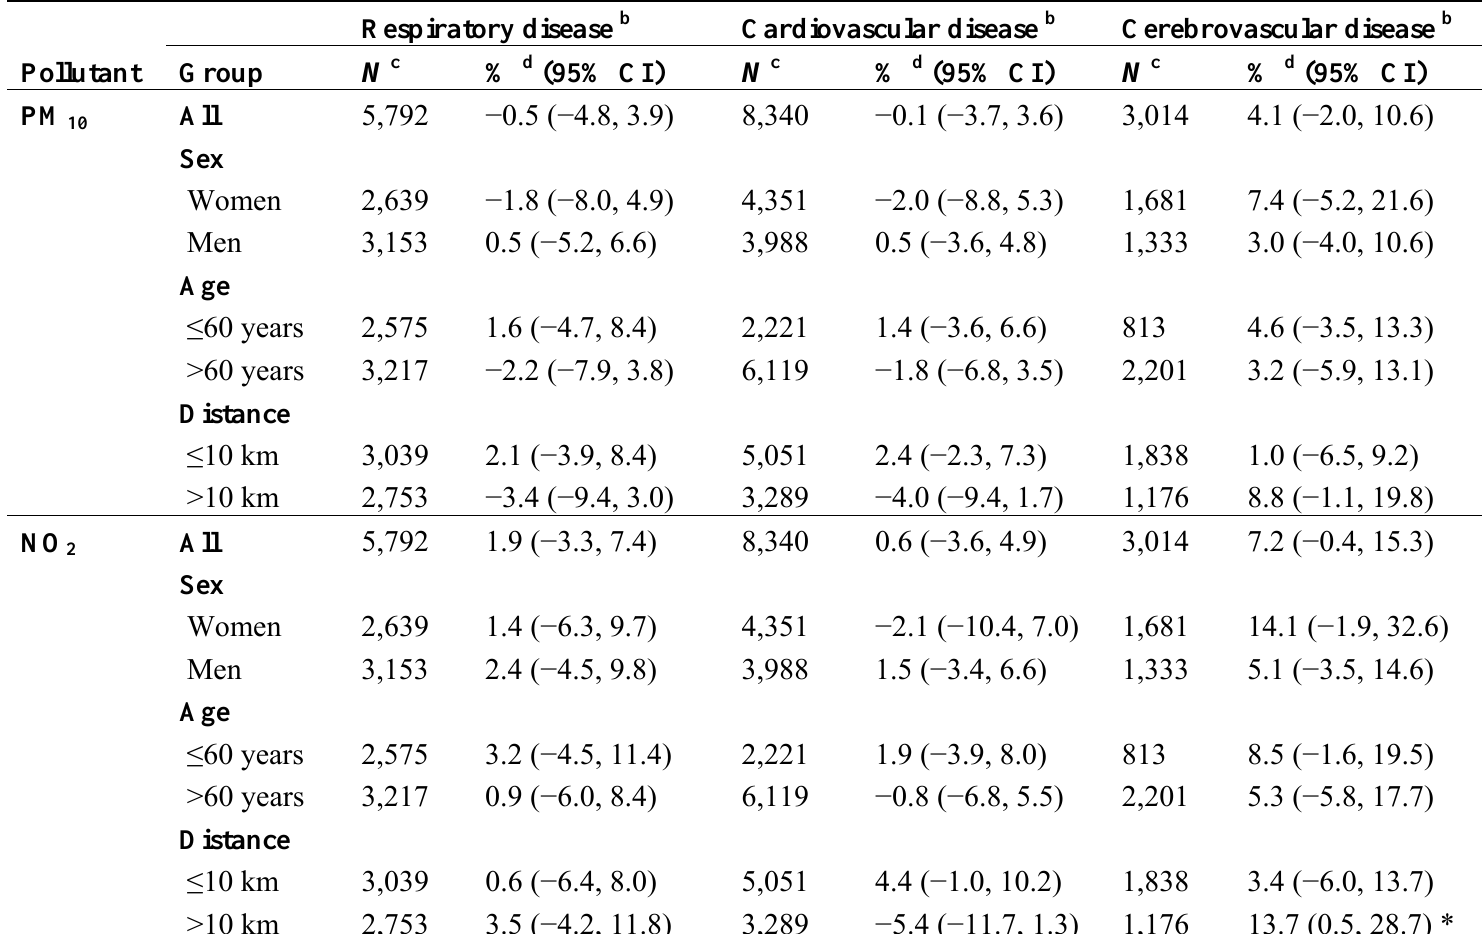
Table 4. Association between air pollutant and cause-specific mortality in Cape Town, South Africa (cold period a ,